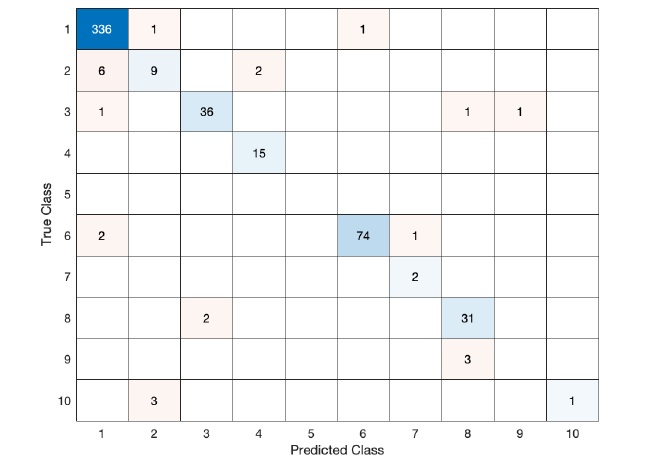
lambda value is equal to 3%.